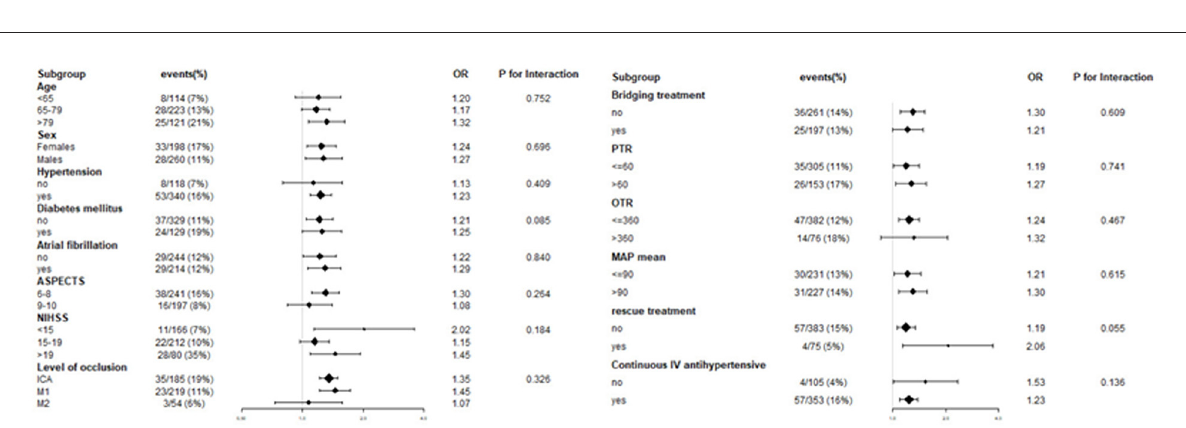
associated with poor functional outcomes at 90 days